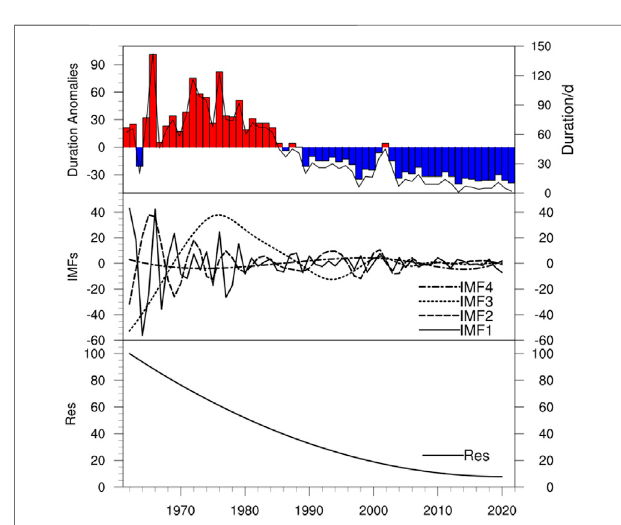
FIGURE 10 | The anomalies evolution and the EEMD results of the annual total number of sand-dust processes.